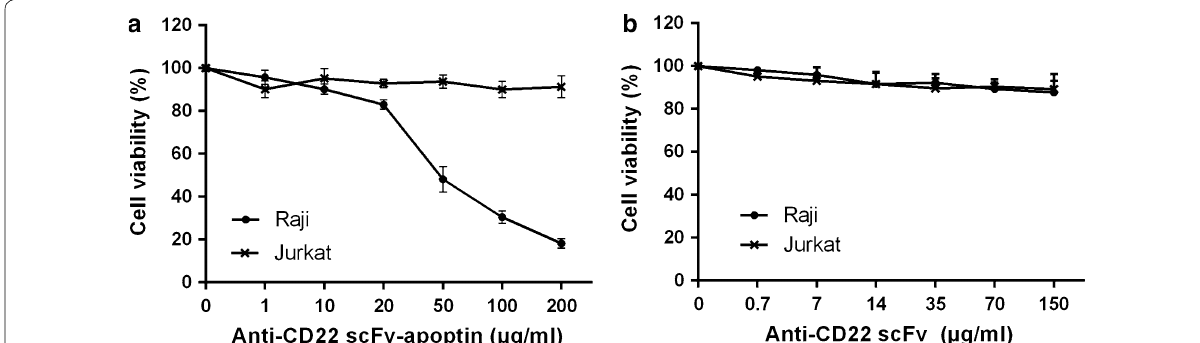
Fig. 3 In vitro dose dependent cytotoxicity curves of anti-CD22 scFv–apoptin and anti-CD22 scFv on the CD22 positive Raji cells and CD22 nega- tive Jurkat cells. The cells were incubated with different concentrations of anti-CD22 scFv–apoptin ( a ) and anti-CD22 scFv ( b ) for 72 h, respectively. The cell viability was measured using standard MTT assay. Data are represented as mean triplicates